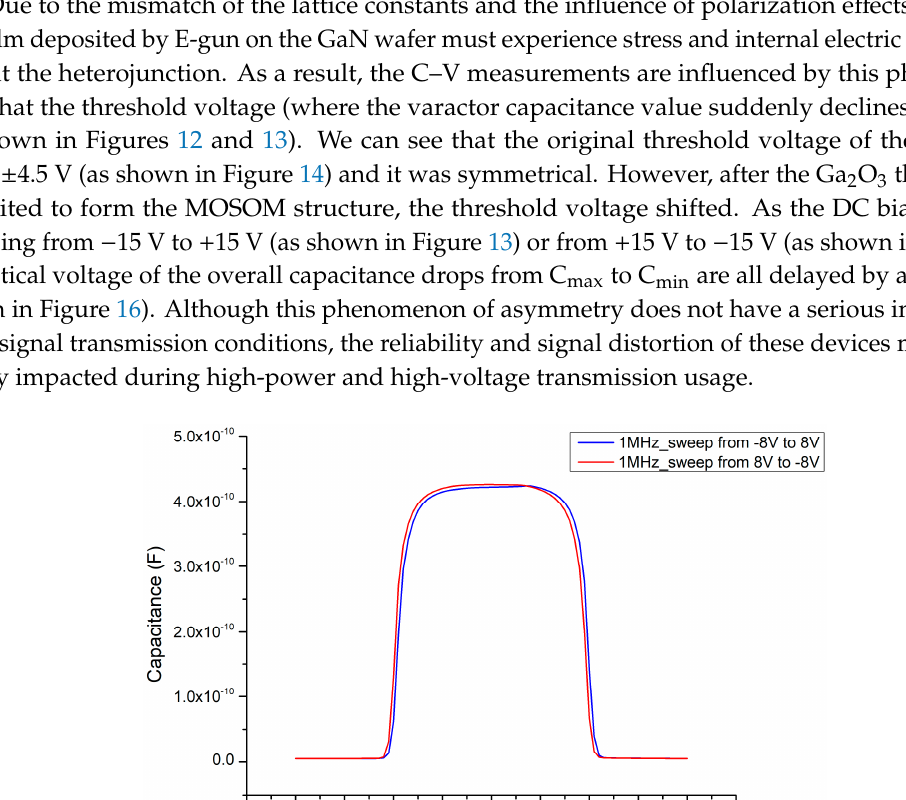
Figure 13. C–V measurement results of the MOSOM varactor (with a 156 nm thick Ga 2 O 3 thin film) from − 15 to +15 V.